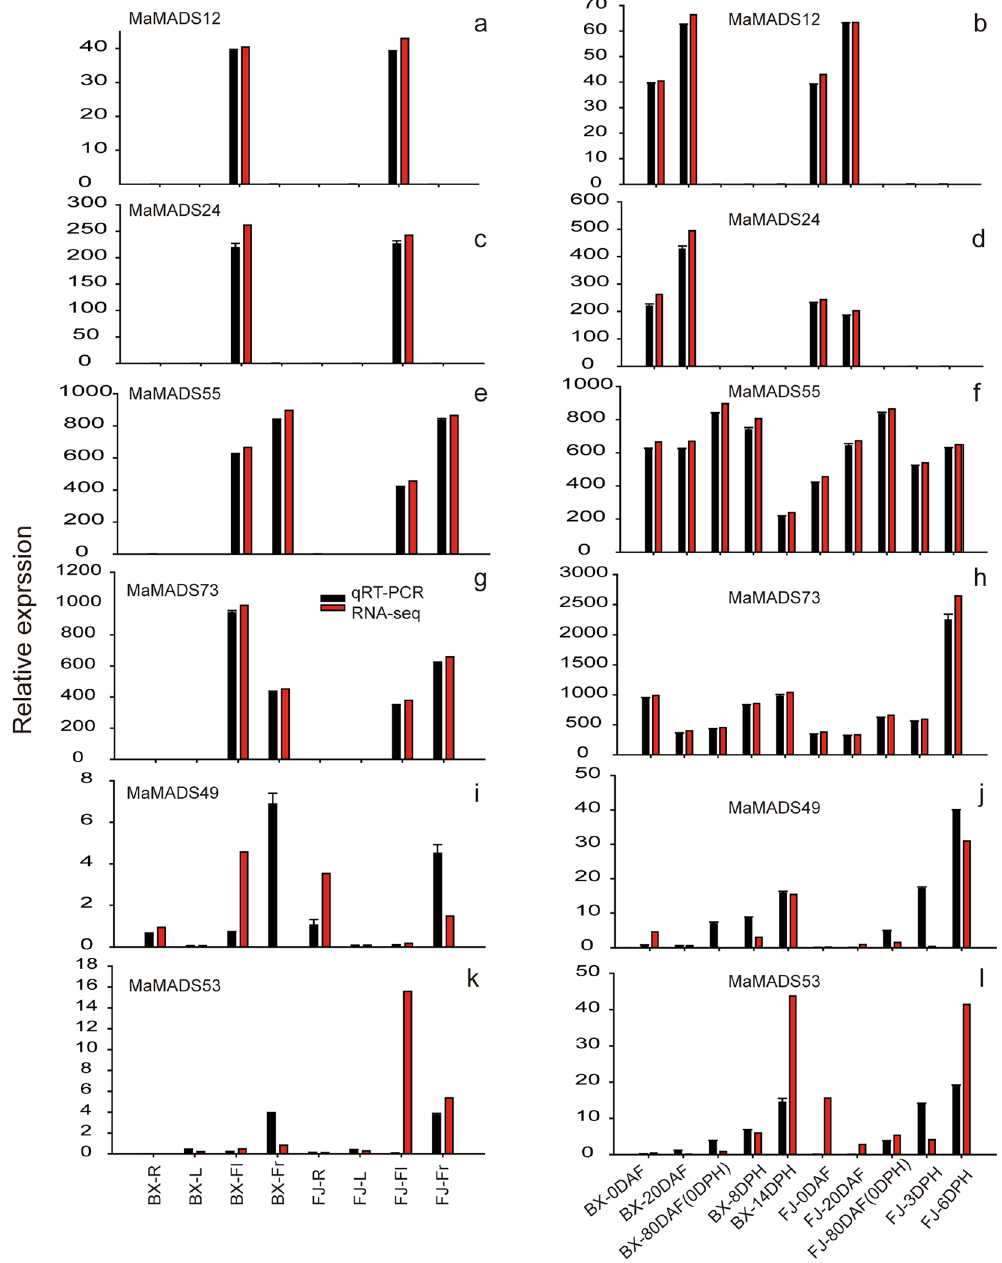
Figure 6. Relative expression of MaMADSes genes in BX and FJ by qRT-PCR. Expression patterns of MaMADS12 , 24 , 55 , 73 , 49 and 53 in different organs ( a , c , e , g , i , k ). Expression patterns of MaMADS12 , 24 , 55 , 73 , 49 and 53 in different stages of fruit development and ripening ( b , d , f , h , j , l ). Data are means ± SD of n = 3 biological replicates. When absent, the bars fall within the dimensions of the